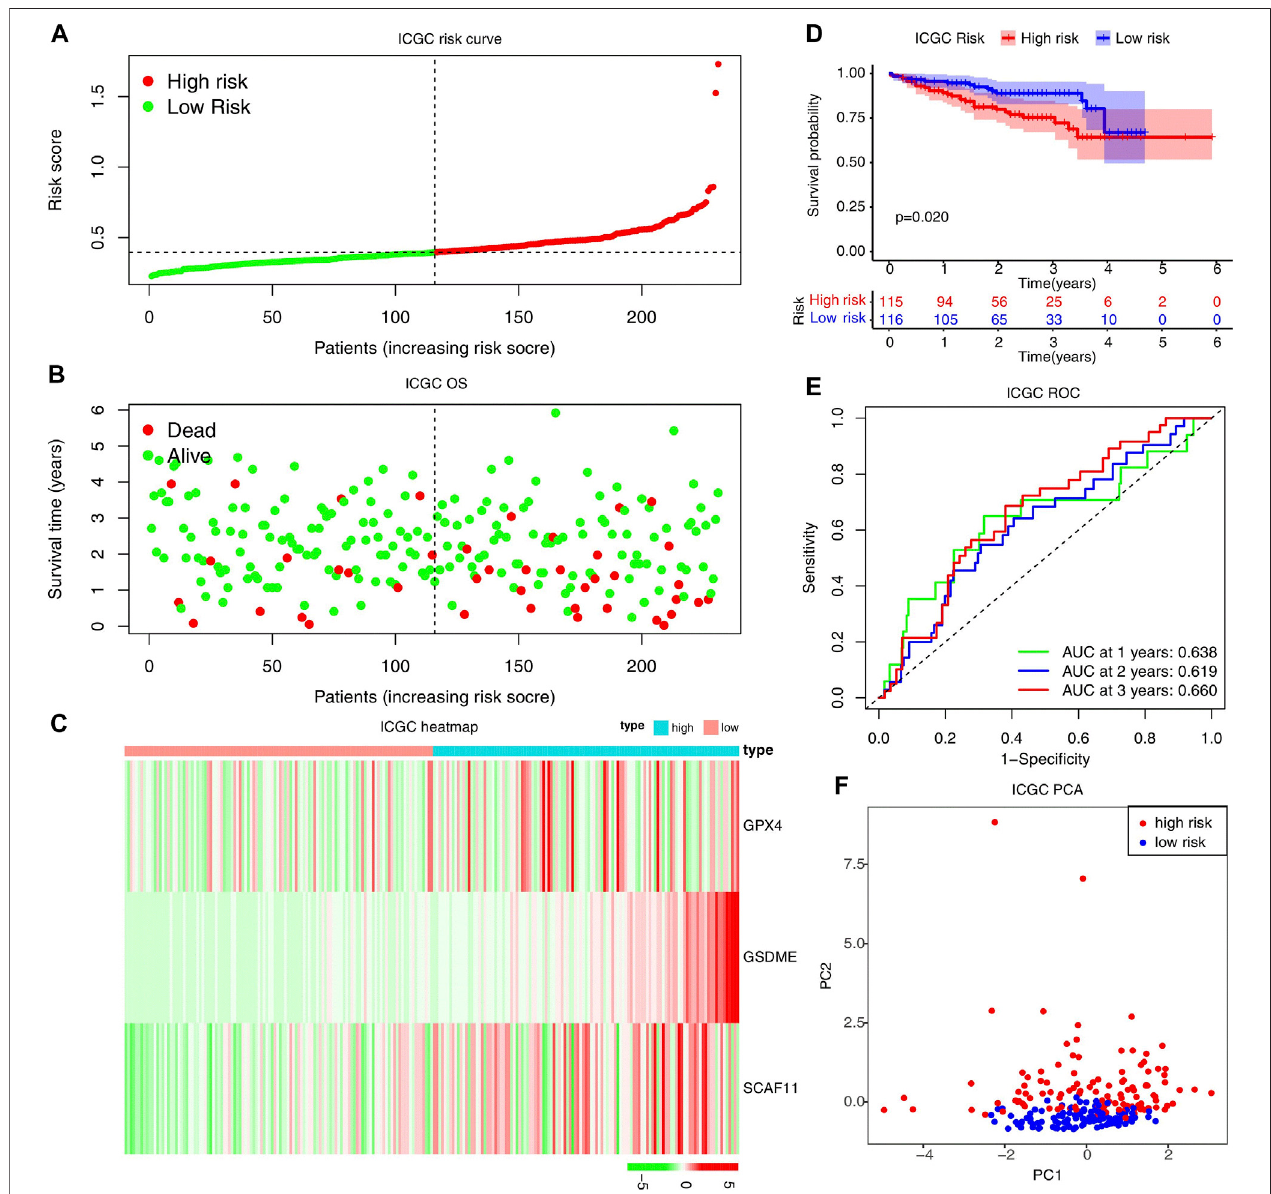
FIGURE 5 | External validation of the risk model in the ICGC cohort. (A – C) Distribution of the risk scores, survival status, and expression of the three pyroptosis- related risk genes in the ICGC cohort. (D) The KM analysis of the overall survival in the high-risk and low-risk groups. (E) The ROC analysis to estimate the predictive ef fi ciency. (F) The PCA analysis of the high-risk and low-risk groups based on the three risk genes.